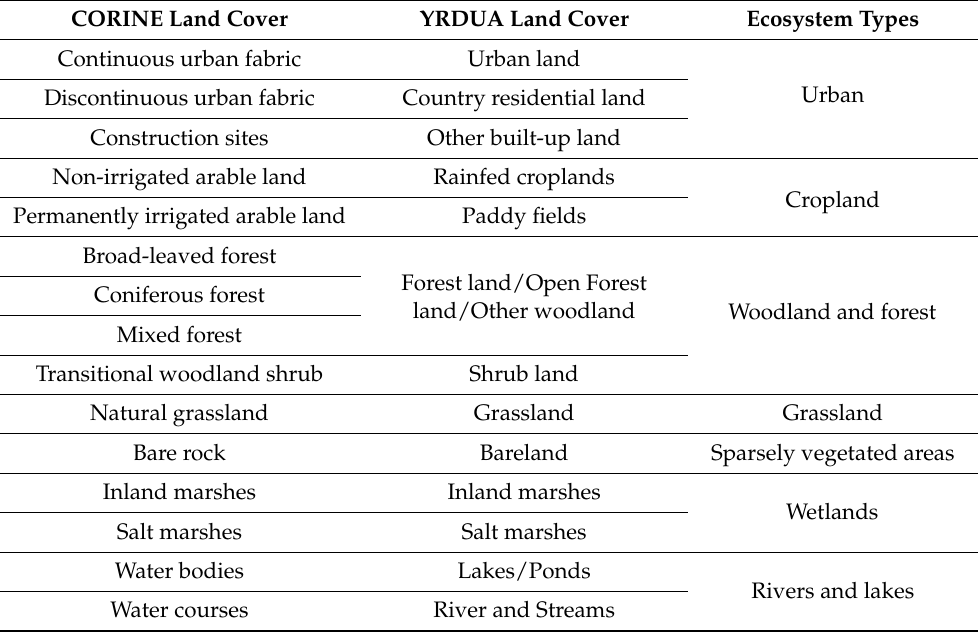
Table 3. Relationship between CORINE and Yangtze River Delta Urban Agglomeration